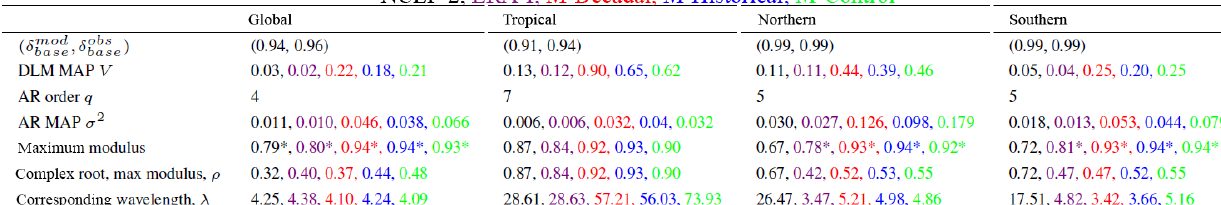
and observation baseline discount factor δ obs . DLM smoothed estimates of level one variance, Table 1. Model baseline discount factor δ mod base base V . AR order q and MAP of AR variance σ 2 . Overall maximum modulus with ∗ indicating correspondence to real roots, maximum complex modulus, and corresponding wavelength (months) calculated from the AR MAP characteristic polynomial.